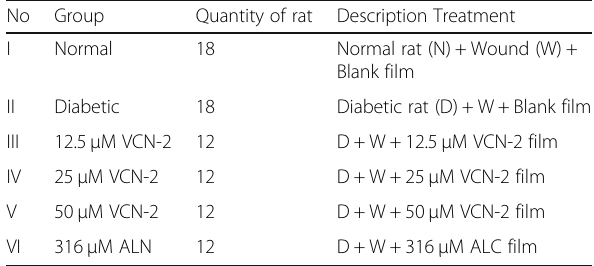
Table 1 Division of animal according to